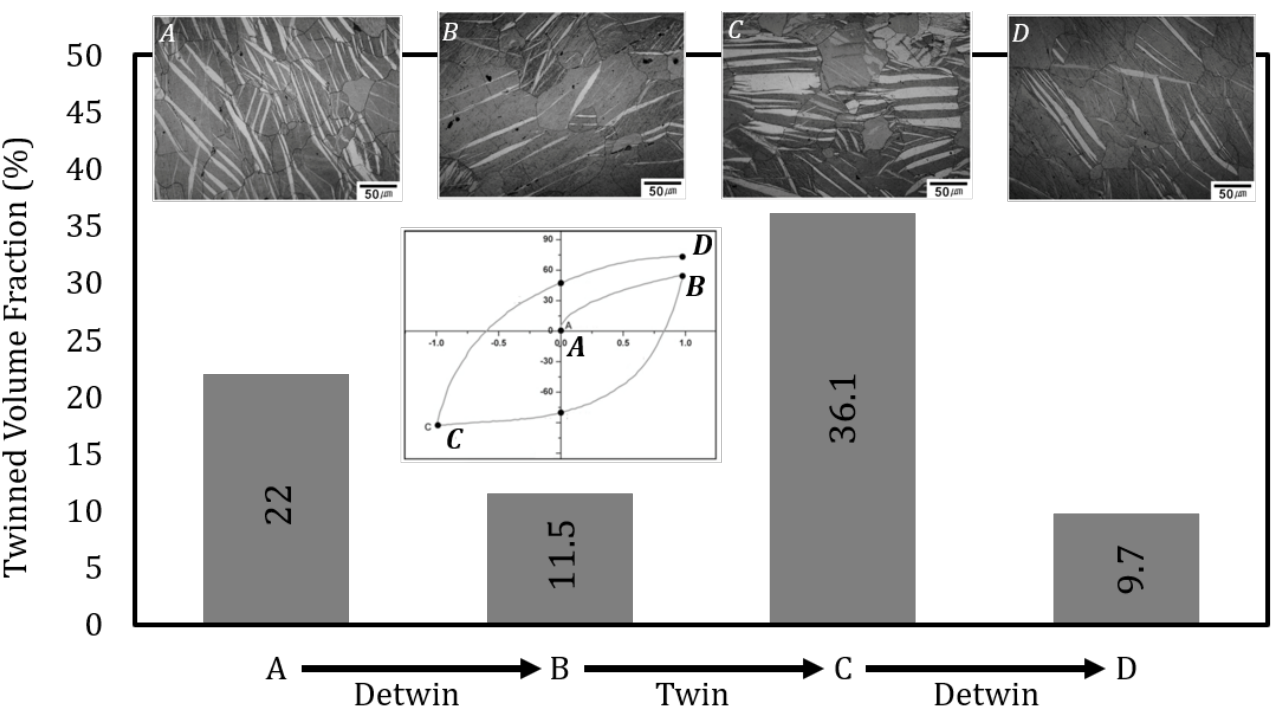
Figure 4. Twinned area fraction during a fatigue cycle of a precompressed Mg AZ31 sample data from [117] representing plastic deformation accommodated by twinning and detwinning